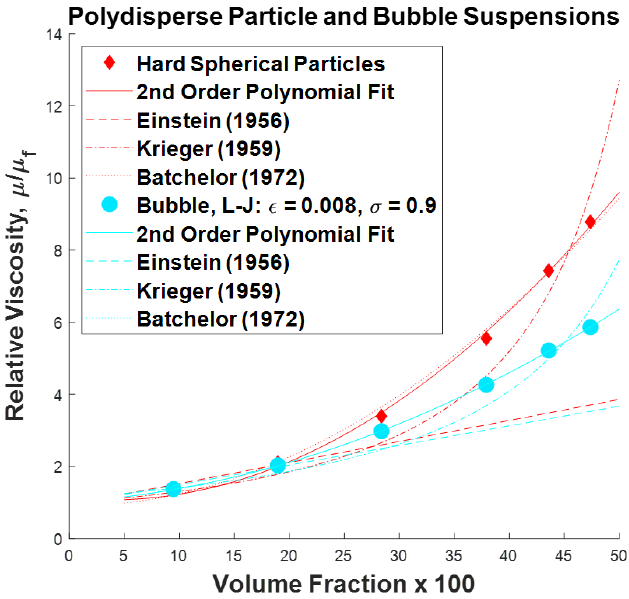
Figure 3. The relative viscosity determined from the simulated results is indicated by points and the lines are the equations fit to the